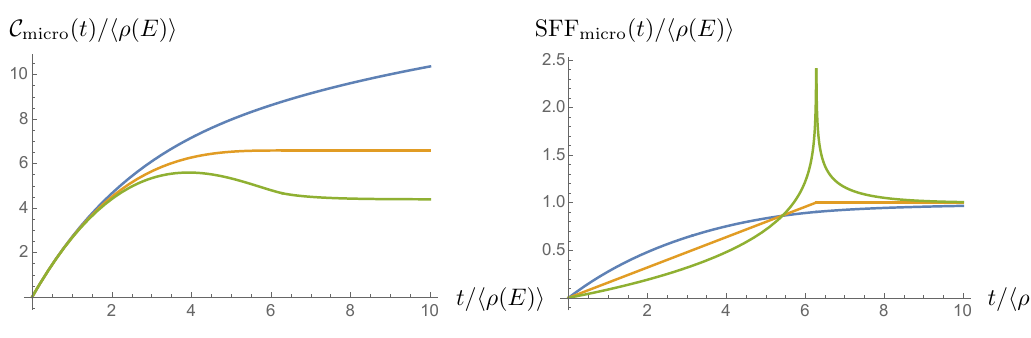
Figure 6 . We show C micro ( t ) and SFF micro ( t ) for GOE (blue), GUE (orange) and GSE (green). early times, C is dominated by the disconnected part of the spectral density two point micro function, and therefore all ensembles display the same linear growth. At late times, the behaviour depends on the symmetry class. Curiously, C does not exhibit a plateau micro in GOE, but grows logarithmically forever as h ρ ( E ) i π 2 log( t ) / 3 . This can be anticipated from the fact that, while the SFF in GUE and GSE reaches a constant at finite t , in h i GOE its asymptotics is given by SFF ( t ) = h ρ ( E ) i 1 − π 2 h ρ ( E ) i 2 / (3 t 2 ) + . . . and micro combining this fact with the relation (7.4). Note however, that for all ensembles there is still a significant cancellation between the disconnected piece of the density two point function giving linear growth and the connected piece cancelling this at late times with the very slow asymptotic logarithmic growth remaining. Nevertheless, it is important to better understand the significance of this logarithmic growth in UV complete gravitational theories that can be related to individual members in the GOE ensemble.